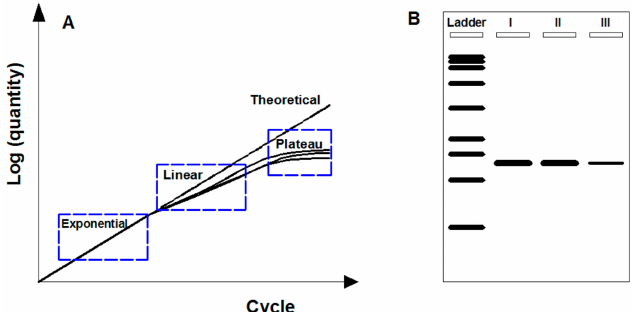
Figure 1. Endpoint PCR-based gene monitoring. ( A ) Description of PCR amplification phases containing both theoretical and practical circumstances. Theoretical amplification: Logarithm of amplified products linear to cycle number. Practical amplification: Consisting of exponential, linear, and plateau phase due to the consumption of reaction reagents. ( B ) Scheme of agarose gel electrophoresis for endpoint amplified products. Target gene can be detected based on size discrimination but not rigorous for quantification.